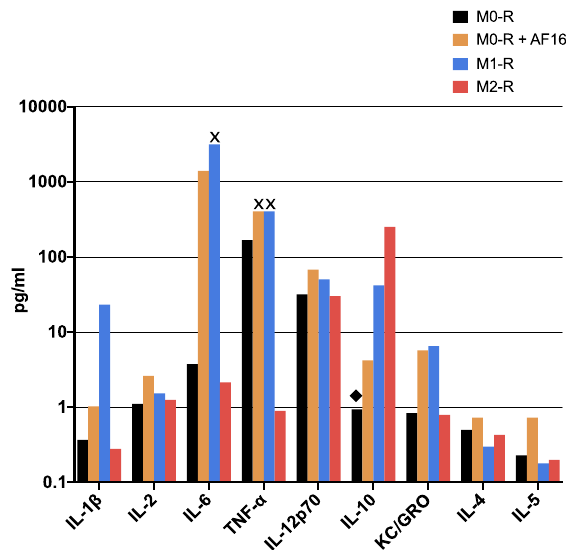
Figure 4. Overview of inflammation-related cytokines upregulated by AF16 treatment of RAW264.7 cells (M0-R). AF16 treatment upregulated all shown factors. Values from untreated cells (black columns) are shown next to AF16-treated cells (orange columns), as well as M1 and M2 differentiated macrophages (blue and red columns, respectively). Values marked with ◆ and x indicate where the original values were replaced by the lowest limit of detection or upper limit of quantification, respectively. Values are shown in pg/ml on a logarithmic